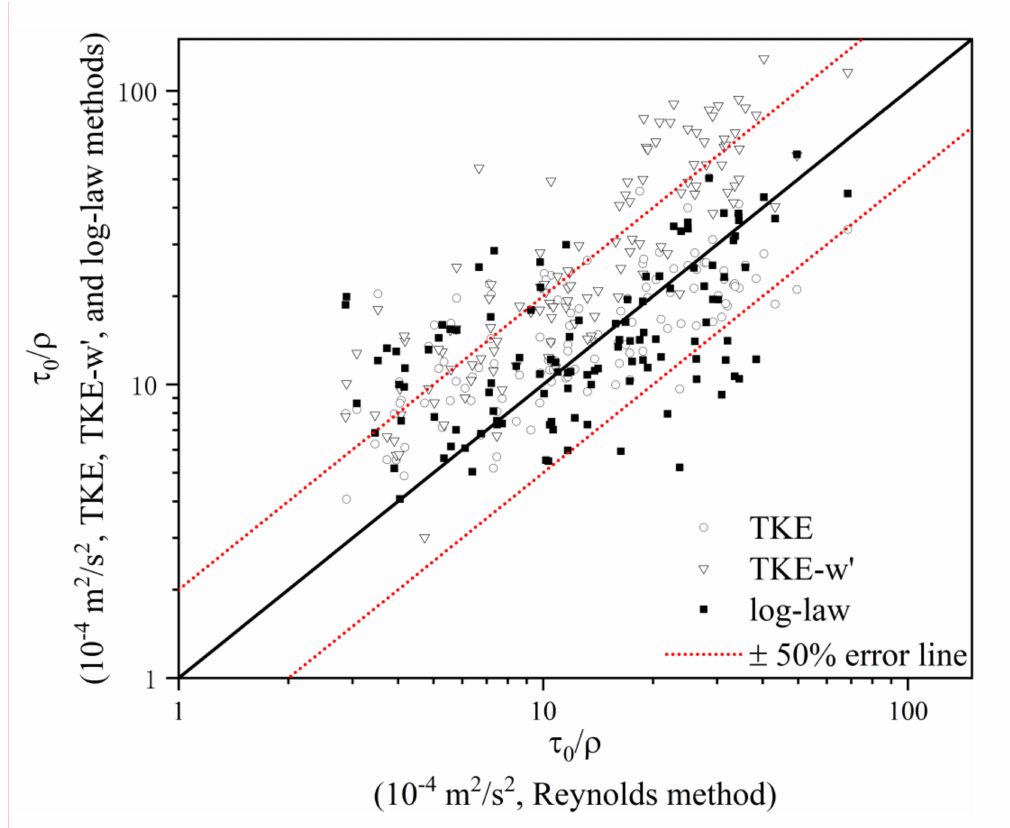
Figure 5. Comparison of Reynolds method with the TKE, TKE-w (cid:48) , and log-law methods.